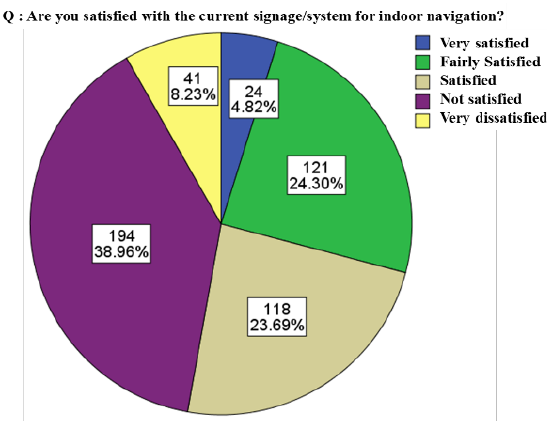
Figure 5. “Do you need indoor navigation?” fan chart.